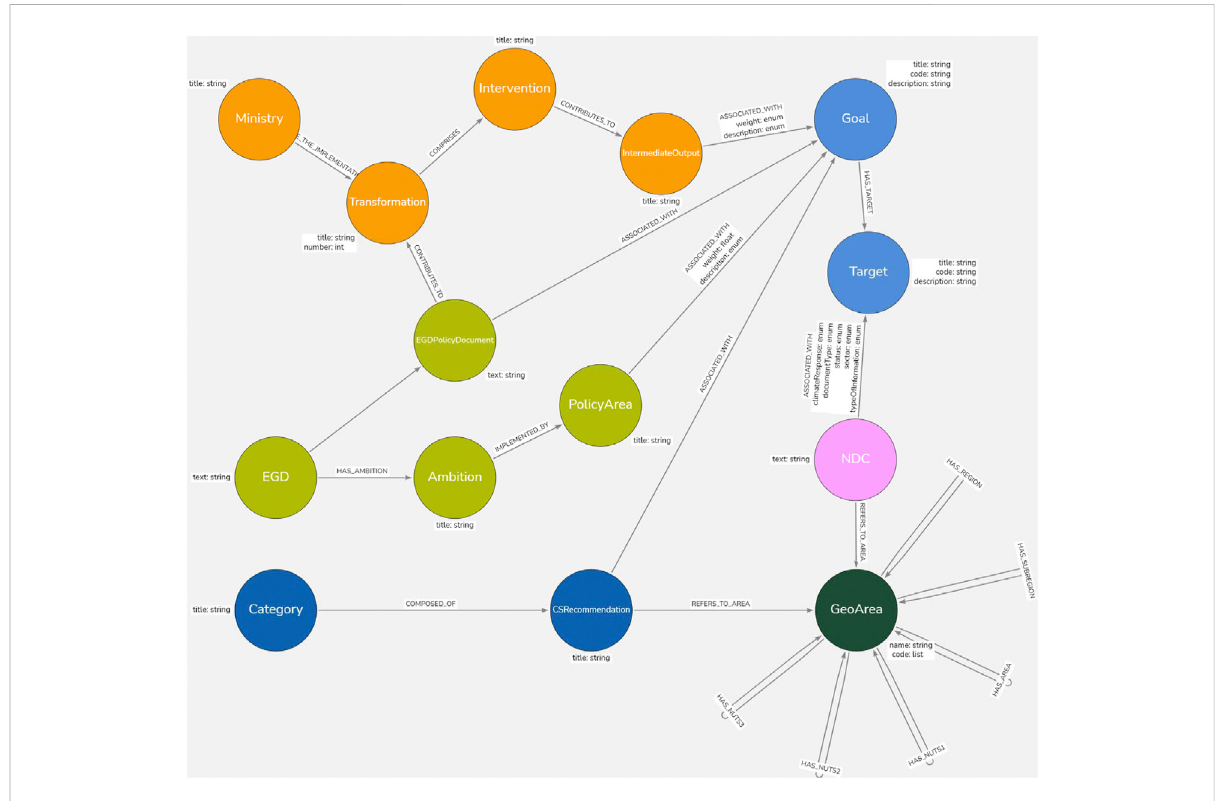
FIGURE 6 Sustainable development policy frameworks in the